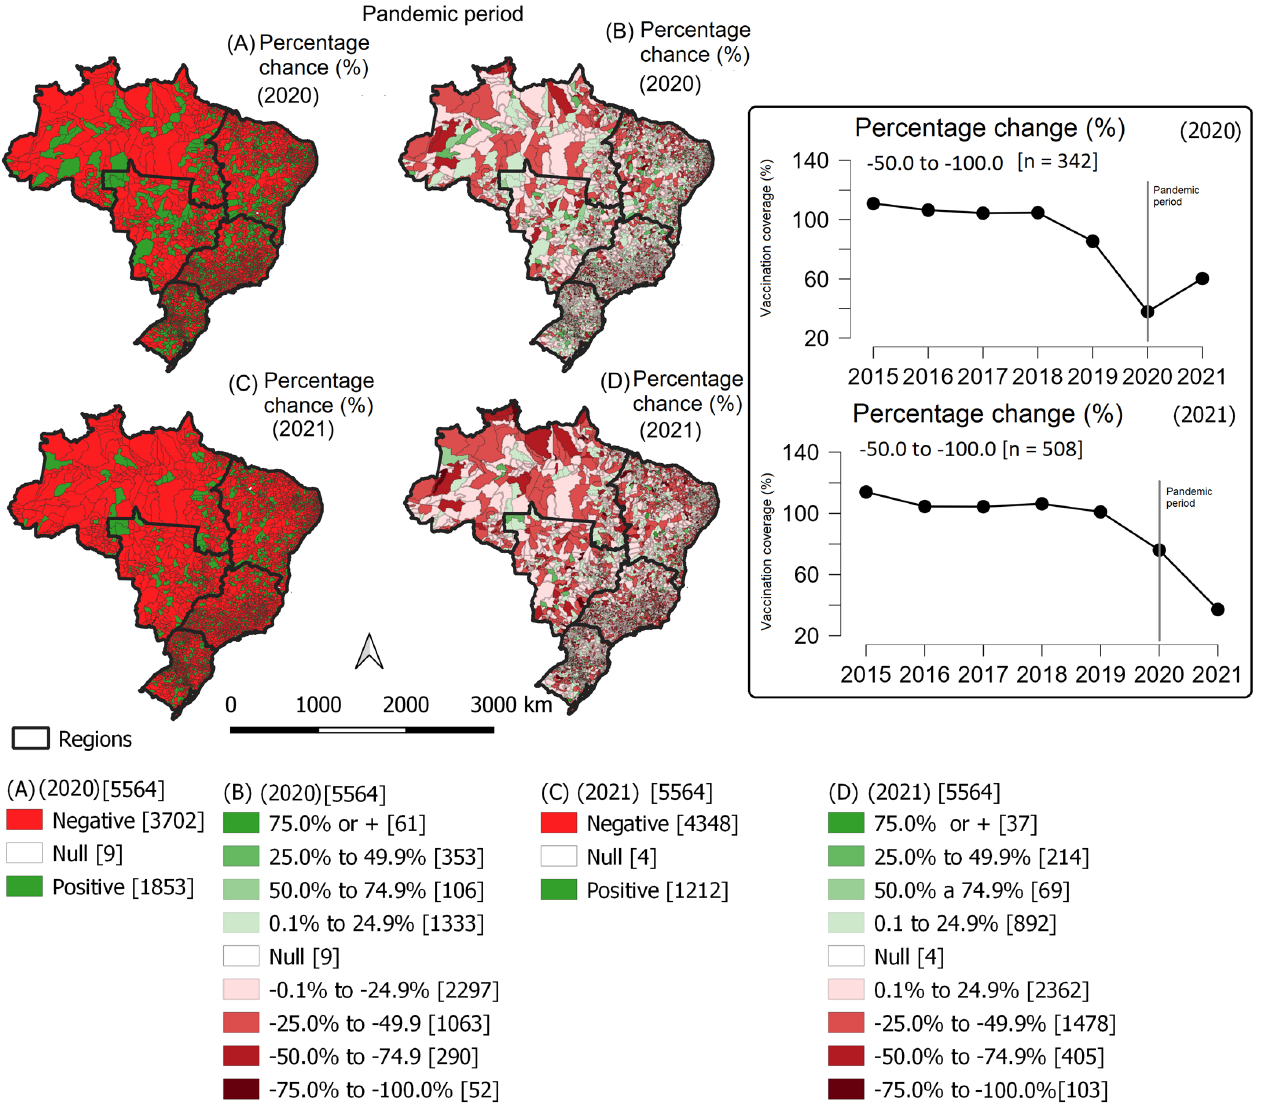
Figure 5. Impact of the COVID ‐ 19 pandemic on human rotavirus vaccination coverage during the first two years of the COVID ‐ 19 pandemic in Brazil, by municipality. Brazil, 2020–2021. Figures ( A , C ) show the classification of the percentage change in vaccination coverage in the years 2020 and 2021 (negative, null, or positive). Figures ( B , D ) show the classification of the percentage change in vaccination coverage.